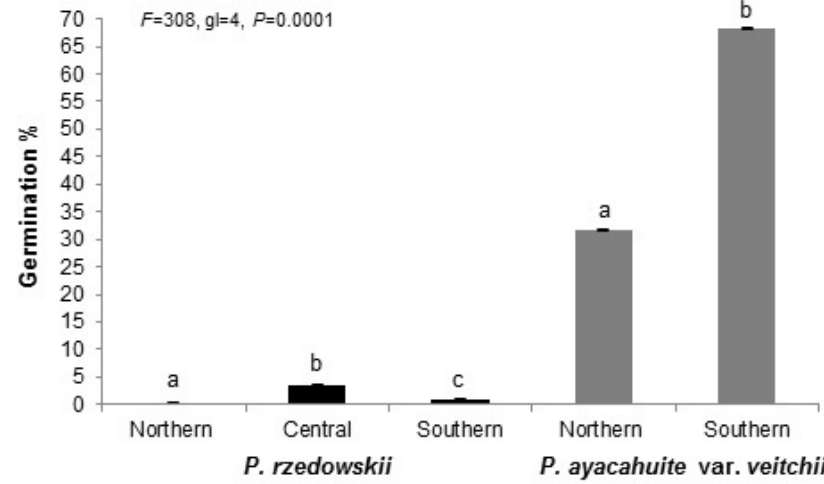
Figure 3. Germination percentages of P. rzedowskii and P. ayacahuite var. veitchii in different study zones. Vertical lines over each bar represent ± one standard error. Letters indicate statistical grouping within each species, based on α = 0.05.